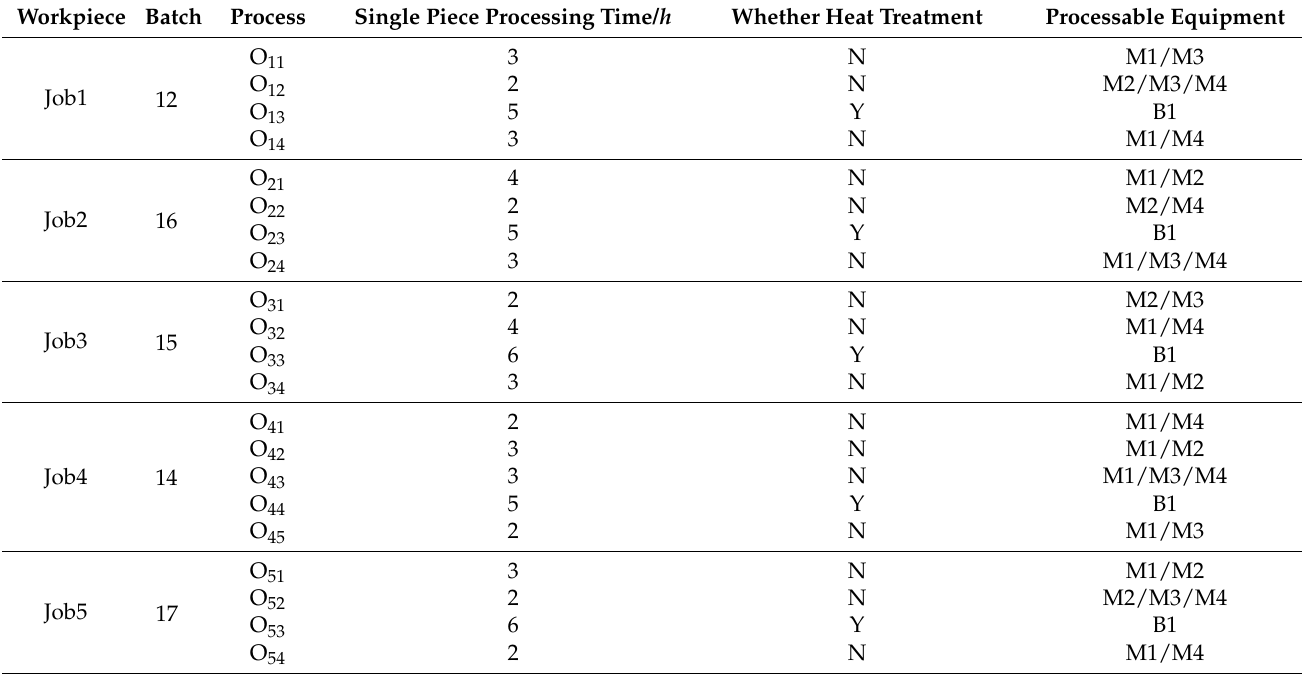
Table 1. Processing scheduling of 5 jobs on 4 equipment and 1 heat treatment equipment.